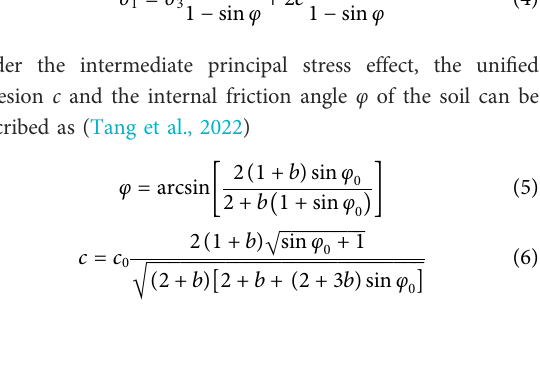
FIGURE 1 Mechanical model of slopes with the seismic